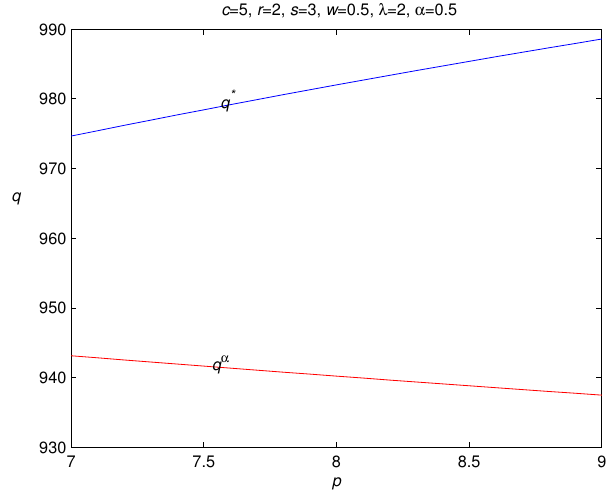
Figure 2. Optimal order quantities q ∗ and q α with different retail price p